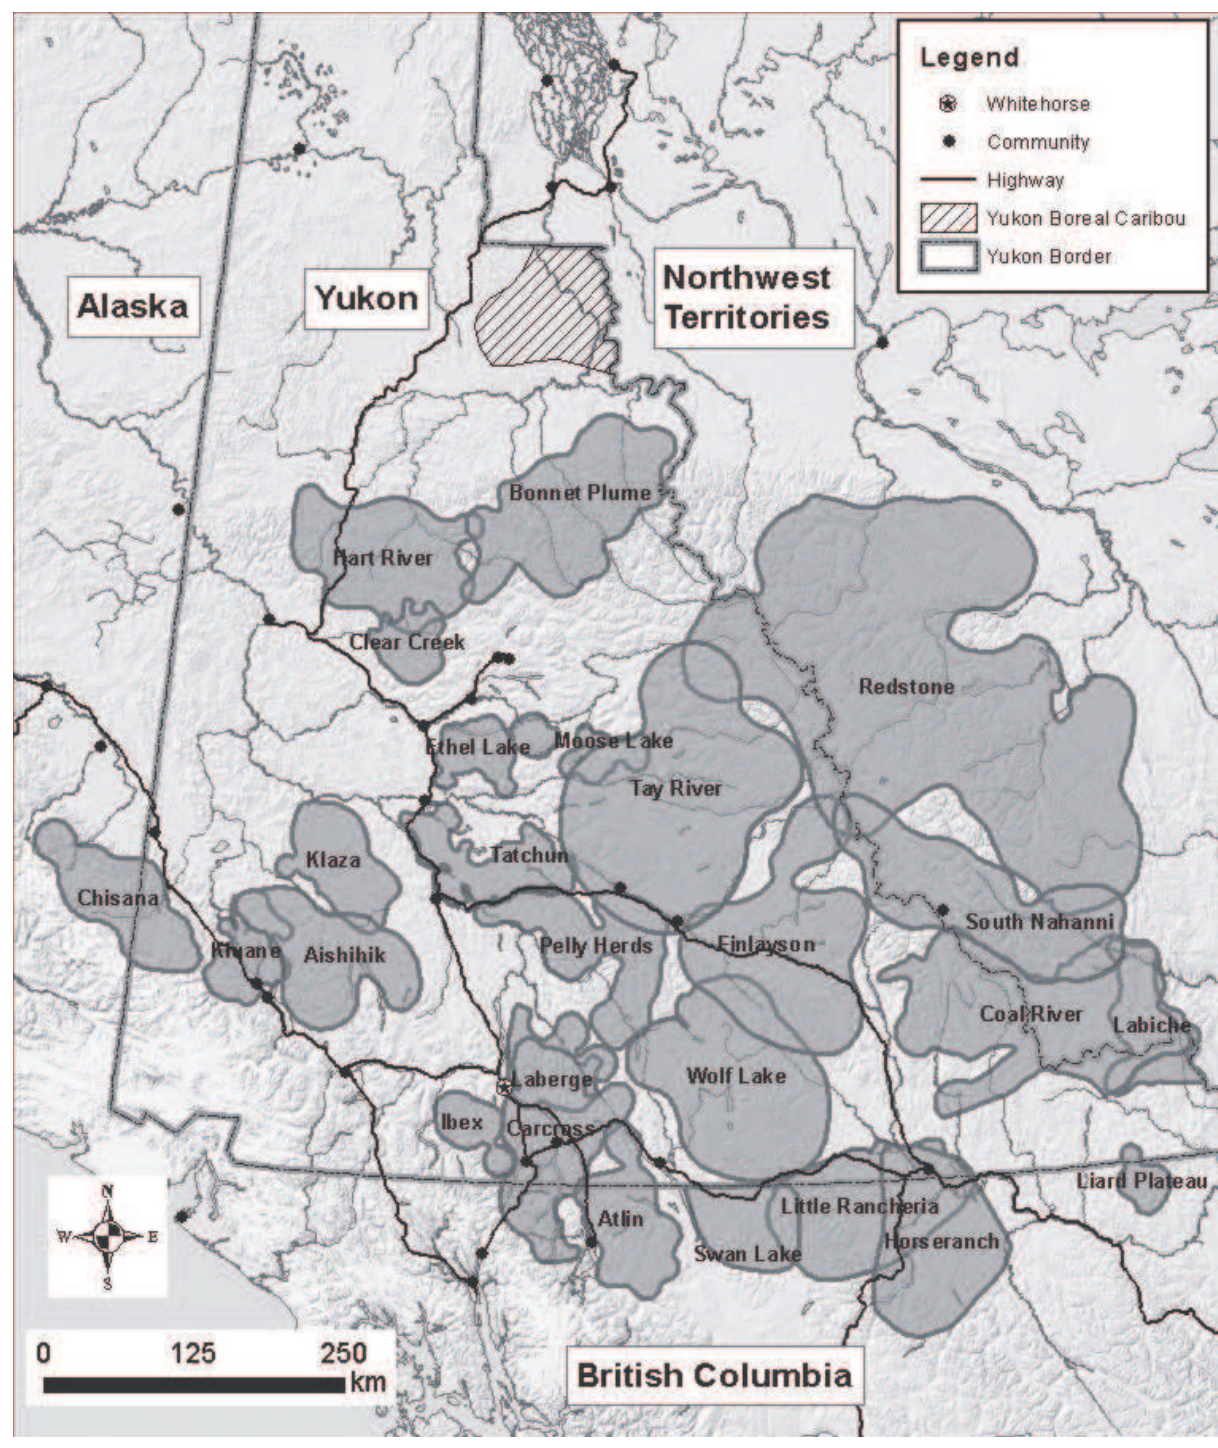
Fig. 1. Distribution of woodland caribou in Yukon, Canada. Northern mountain herds are individually labelled. The hatched area in the northeast Yukon represents the general range of boreal caribou in